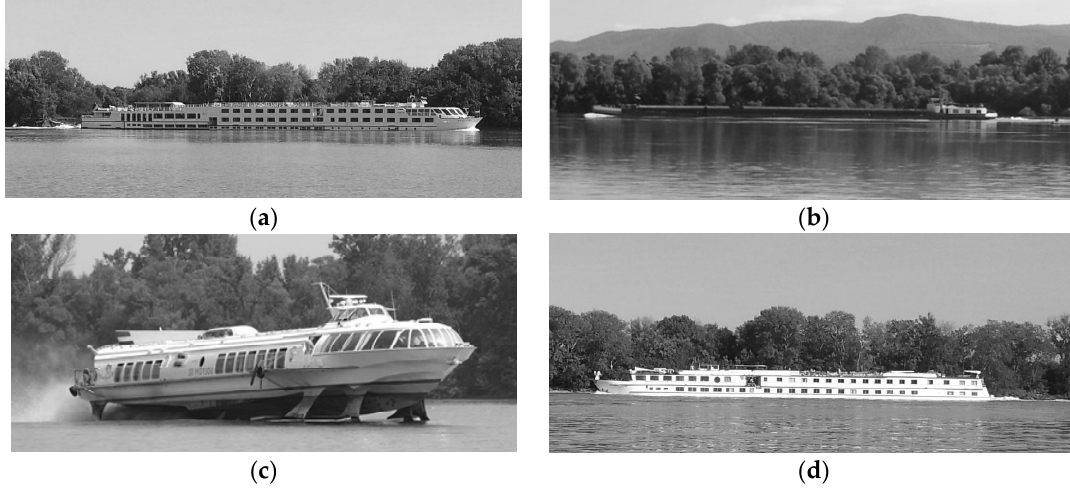
Figure 2. Photos of the investigated ships: ( a ) passenger vessel #1 (downstream direction); ( b ) barge (upstream direction); ( c ) hydrofoil (downstream direction) [19]; and ( d ) passenger vessel #2 (upstream direction).